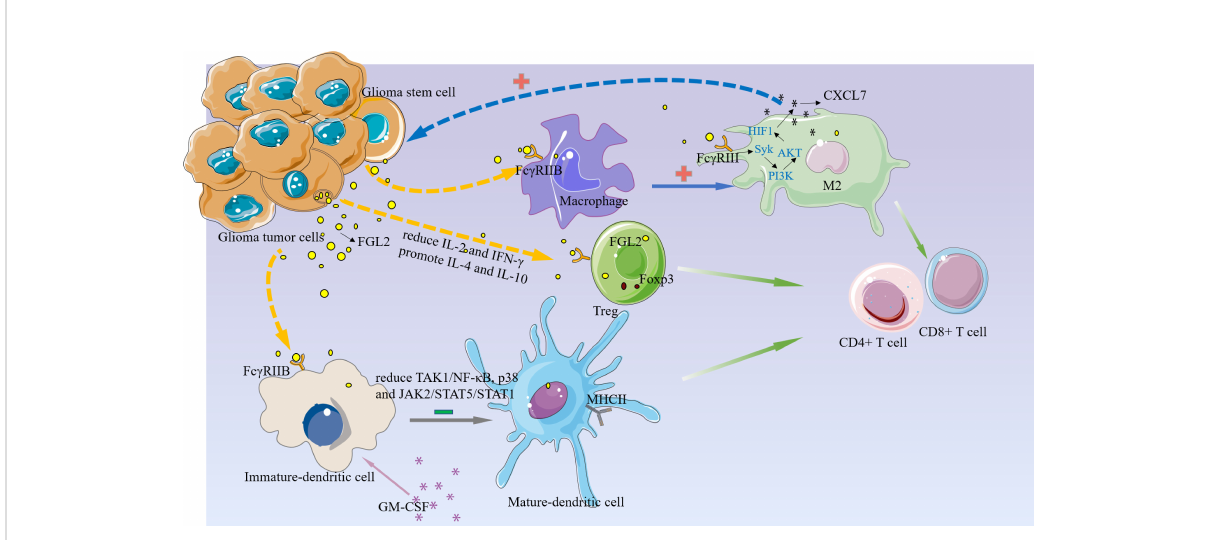
FIGURE 3 FGL2 plays an immunosuppressive function in the glioma microenvironment.1, FGL2 secreted by tumor cells binds to FCGR2B on immature DC cells and inhibits DC cell maturation and thus T cell proliferation by blocking the TAK1/NF- k B, p38, and JAK2/STAT5/STAT1 pathways.2, FGL2 inhibits the immune activators IL-2 and IFN- g production, promotes immunosuppressive factors IL-4 and IL-10, increases Treg, and inhibits T- cell activation.3, FGL2 induces macrophages toward the M2 phenotype and produces CXCL7 in M2 cells via the FCGR2B/Syk/PI3K/AKT/HIF1 a pathway, and CXCL7, in turn, acts on GSC to promote glioma cell stemness